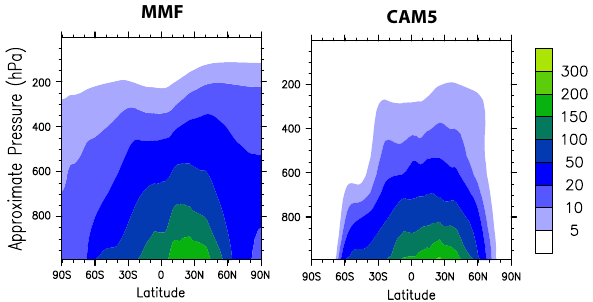
Figure 10 Fig. 10. Annual-averaged zonal-mean CCN concentrations at 0.1% supersaturation in the PD simulations in the MMF (left panel) and CAM5 (right